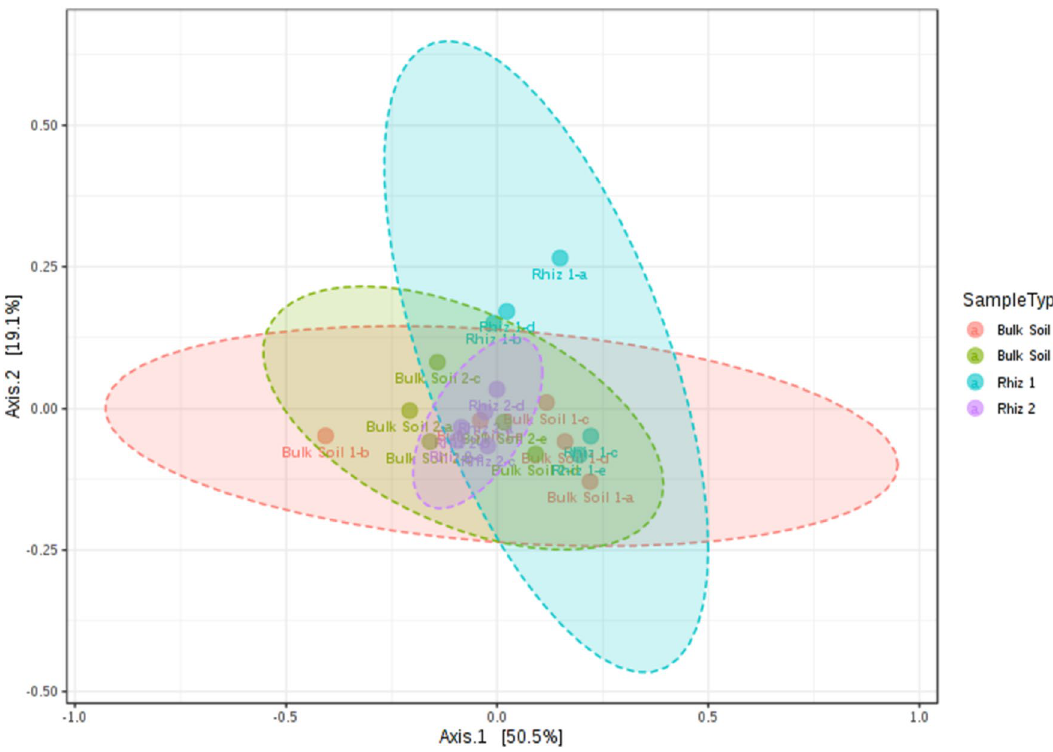
Figure 3. Beta diversity evaluation at the genus level: Principal Coordinate Analysis (PCoA) based on Bray–Curtis metrics shows the dissimilarity of microbial communities in bulk soil and rhizosphere according to sampling time. [ANOSIM] R: 0.259; p-value < 0.003. Beta diversity analysis was performed using MicrobiomeAnalyst, a free available on-line software (https:// www. micro biome analy st.